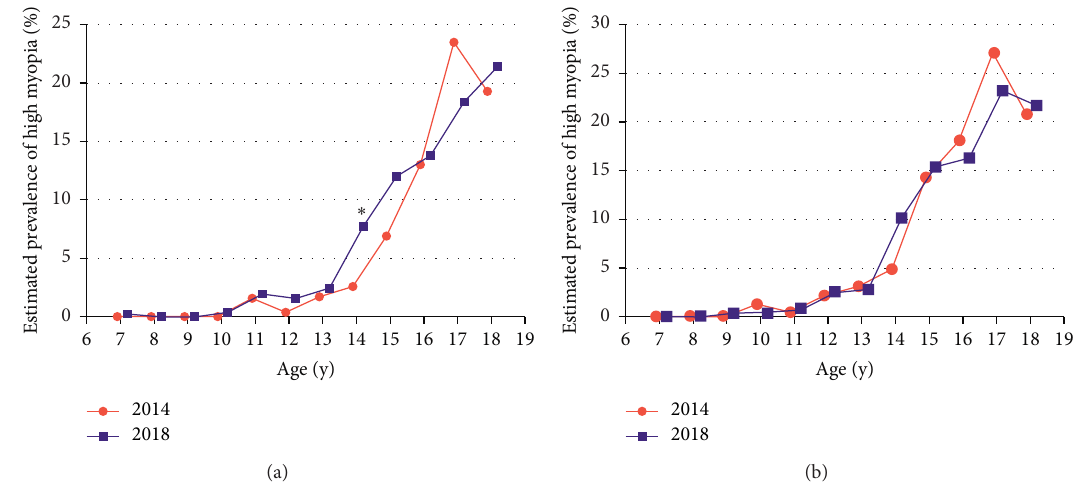
Figure 3: Trends of prevalence of high myopia defined by SE ≤ − 6.00 D (a) and by AL ＞ 26 mm (b) in children from 7- to 18-year-olds in 2014 and